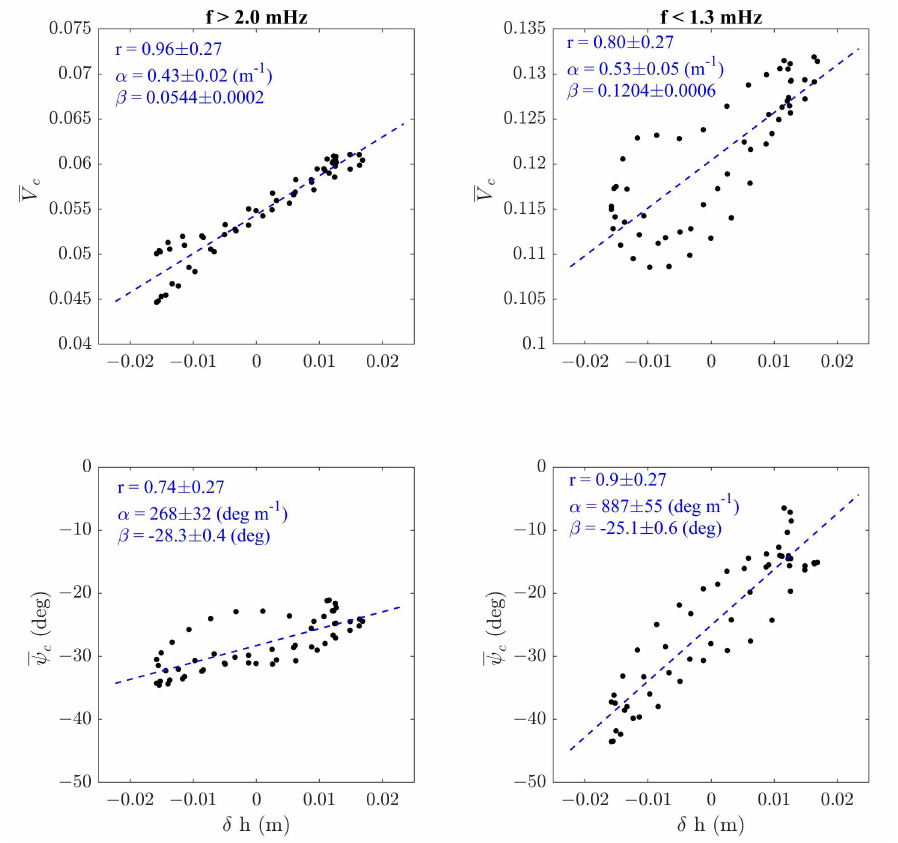
Figure 8. Cross-correlation between averaged composites mean amplitude V c (top panels) and phase ψ (bottom panels) of transfer functions at LMP for f > 2.0 (left panels) and f < 1.3 mHz (right panels) c and barotropic sea level fluctuations δ h at O1 tidal mode derived from SEA (see text for details). α and β coefficients of linear fit are shown together with the correlation coefficient r and their 95% threshold estimated by null-hypothesis with 55 degrees of